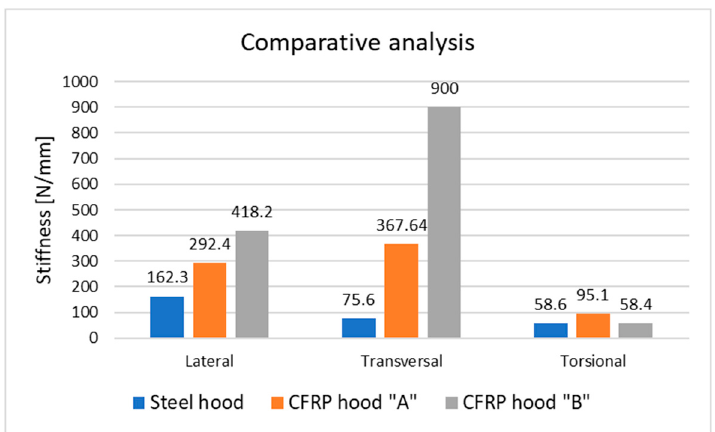
Figure 20. Comparative analysis of the stiffness of investigated hoods.